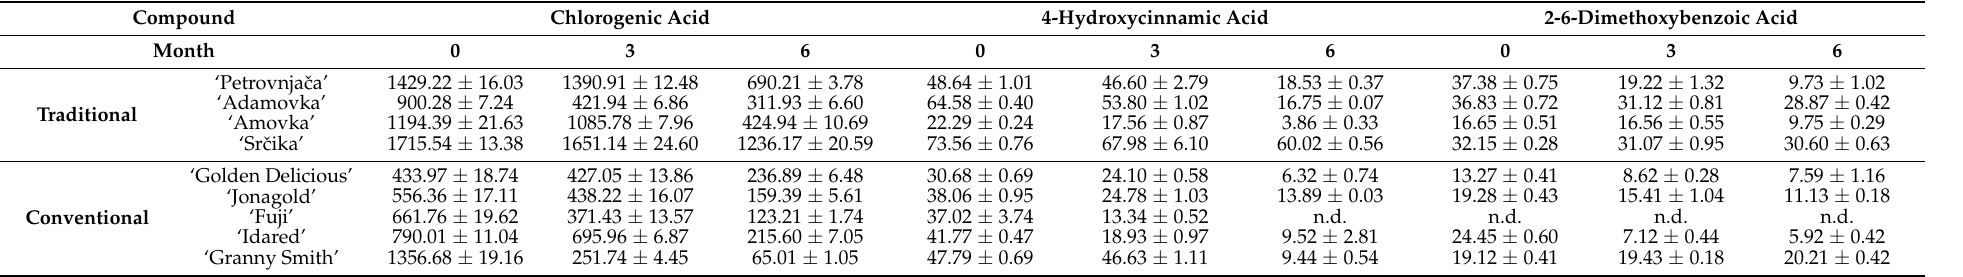
Table 6. The content of non-flavonoids ( µ g/g dw a ) in the traditional and conventional apple